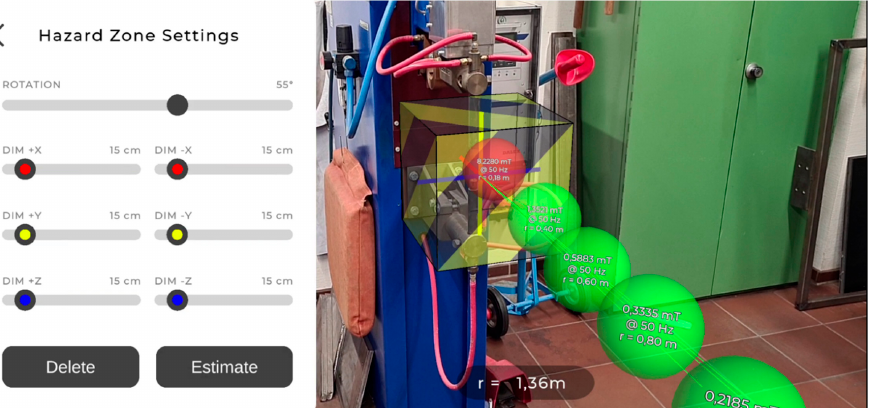
Figure 3. The hazard zone represents a volume within which the measured flux densities exceed a given limit value. In other words, it visualizes safety distances around the reference point. The dimensions can be estimated based on the measurements, and they can be manually adjusted.